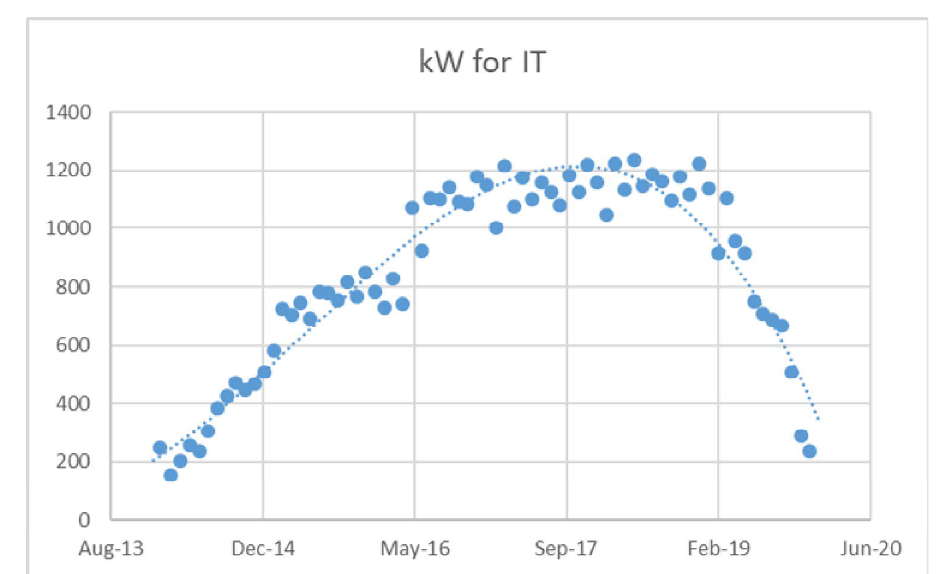
Figure 3 : Power consumption (kW) for our co-located IT equipment over the years.